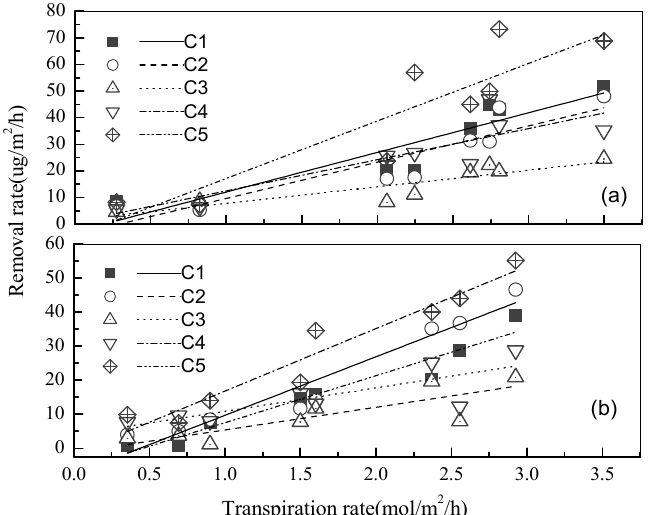
Figure 7. Relationship between the removal rates of C 1 –C 5 aldehydes and the transpiration rate for the two houseplant species. ( a ) Schefflera octophylla (Lour.) Harms (R 2 = 0.720–0.837); ( b ) Chamaedorea elegans (R 2 = 0.607–0.932). C 1 : formaldehyde; C 2 : acetaldehyde; C 3 : propionaldehyde; C 4 :